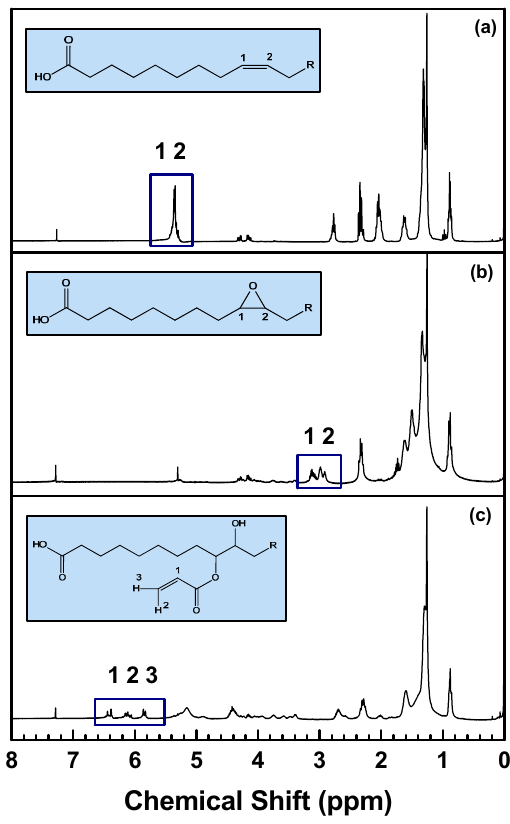
Figure 1. 1 H ‐ NMR spectrum of ( a ) fatty acids of soybean oil, ( b ) epoxidized fatty acids, and ( c ) acrylated fatty